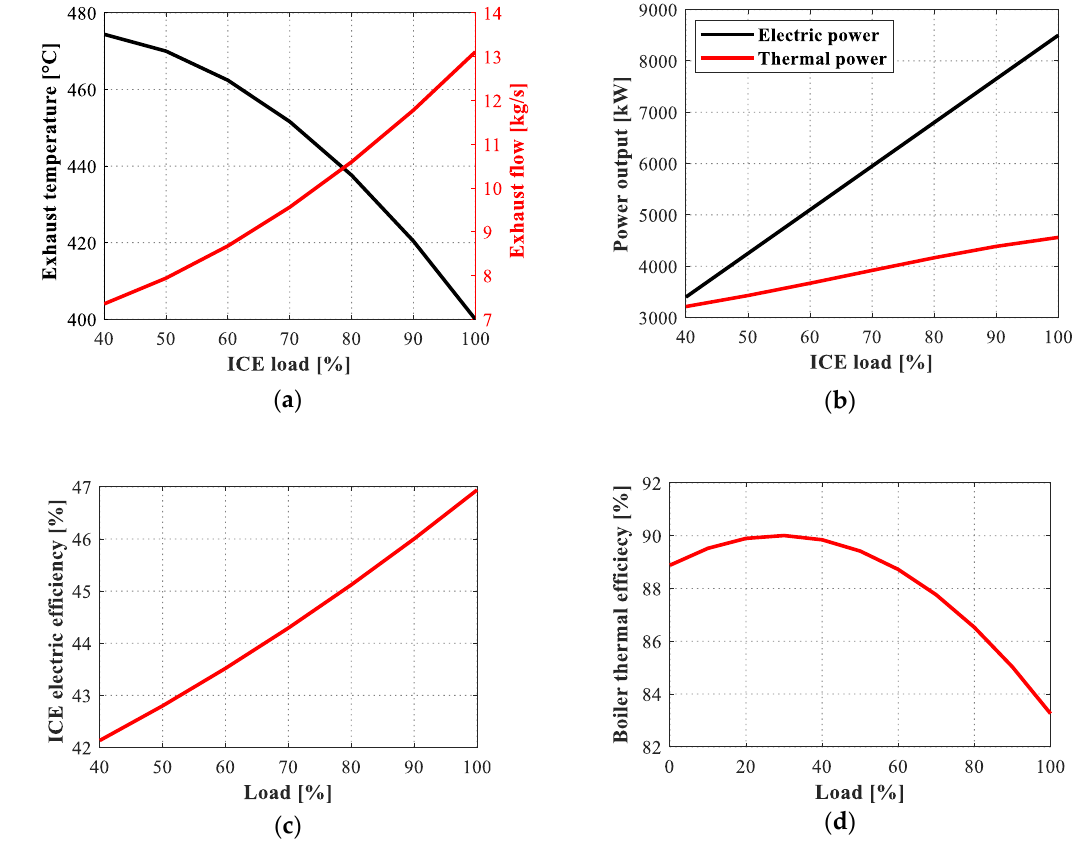
Figure 3. Performance of internal combustion engines (ICEs) and back-up boilers at part-load conditions: ( a ) ICE exhaust gas conditions at part-load operation; ( b ) ICE electric and thermal power output at part-load operation; ( c ) ICE electric e ffi ciency at part-load operation; ( d ) Boilers thermal e ffi ciency at part-load operation.